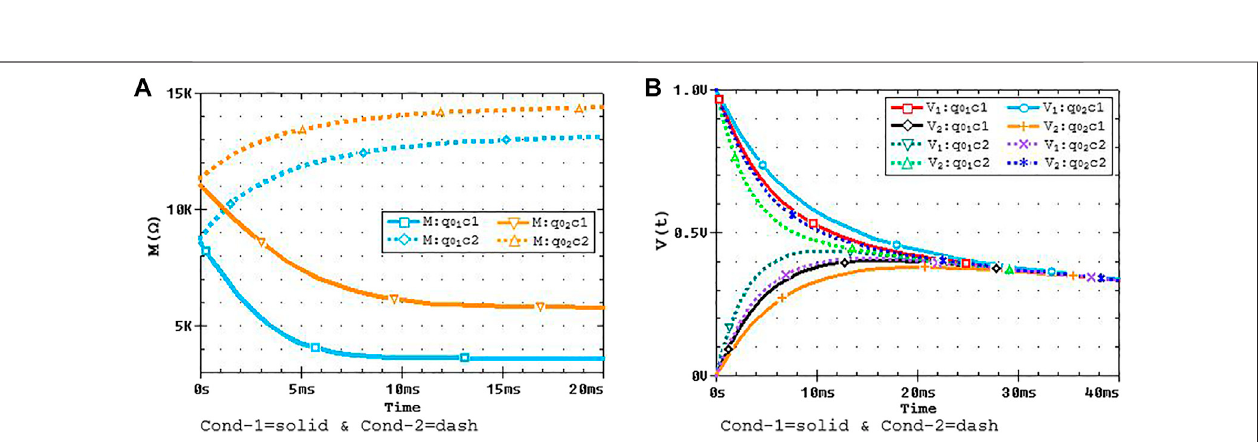
(cid:1) 0 V , V (cid:1) 1 V for Cond-2. (A) Memristance transition; (B) time evolution of V 1 0 2 0